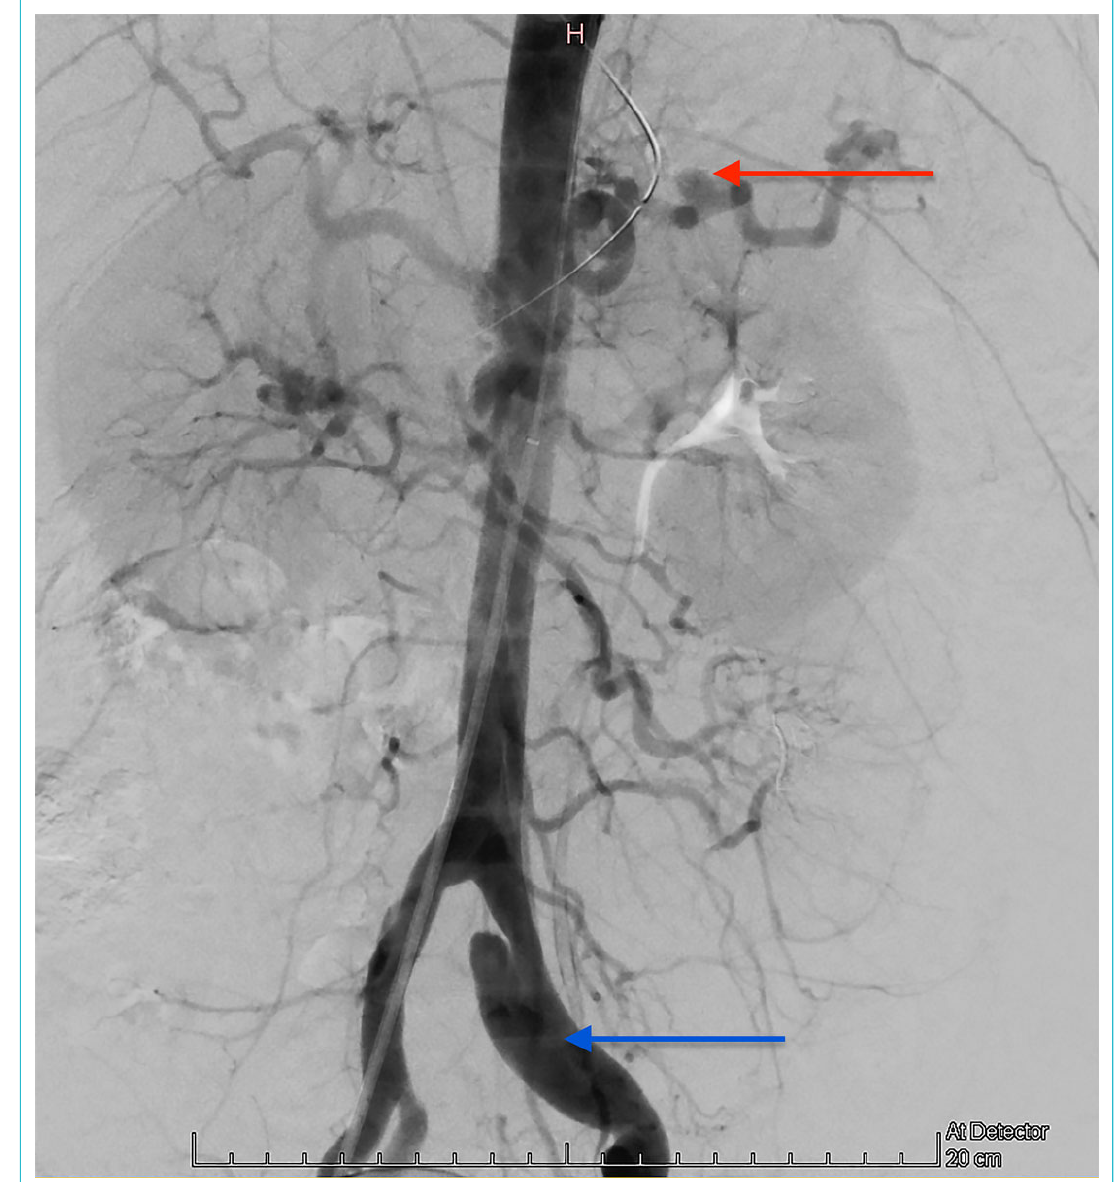
Figure 4: Emergency angiography showing a pathological aspect of the splanchnic arteries, suggesting a systemic vascular condition (splenic artery aneurysm – red arrow – and left common iliac artery dissection – blue arrow). No active haemorrhage in the territory of the inferior mesenteric artery was